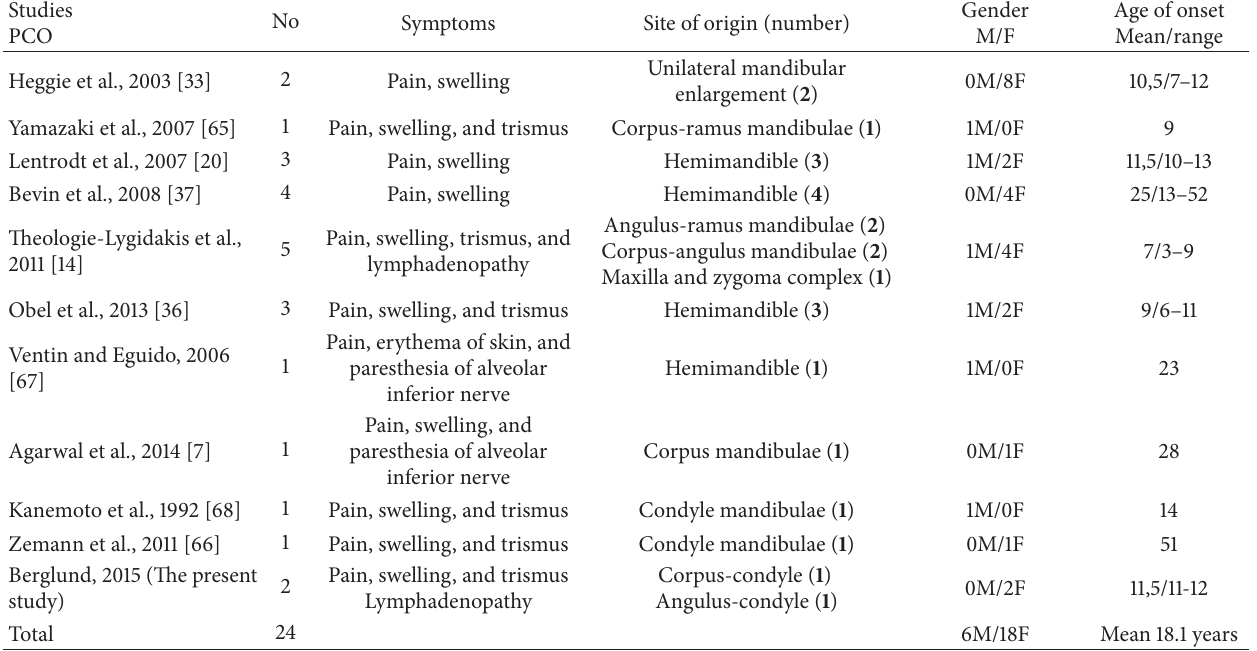
Figure 6: Bone scintigraphy of patient case 2 shows increased uptake of tracer at the right side of the mandible. Table 1: Demographic and clinical